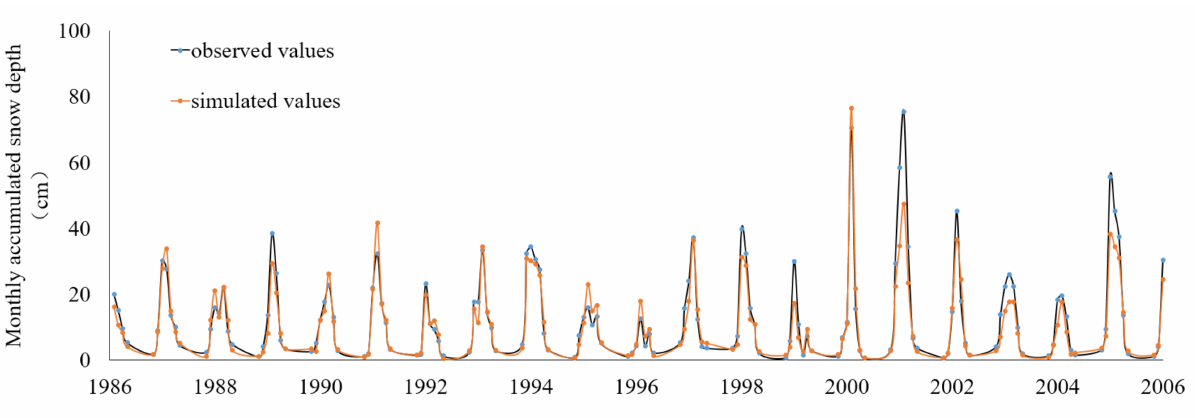
Figure 6. Variation of simulated and observed monthly snow depths (October to April; same